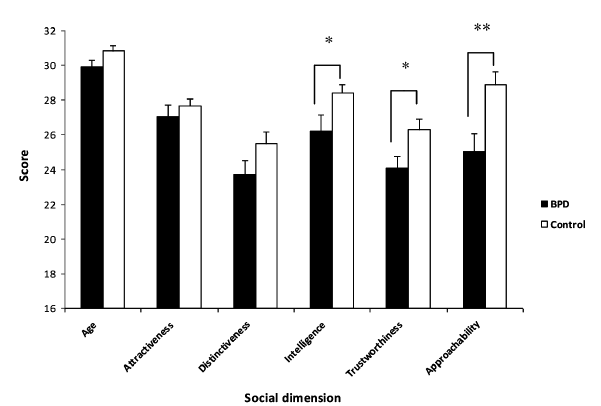
Figure 1. Graph of social judgement scores for each of six dimensions. The BPD group scored significantly lower than the control group on judgements of intelligence, trustworthiness and approachability.